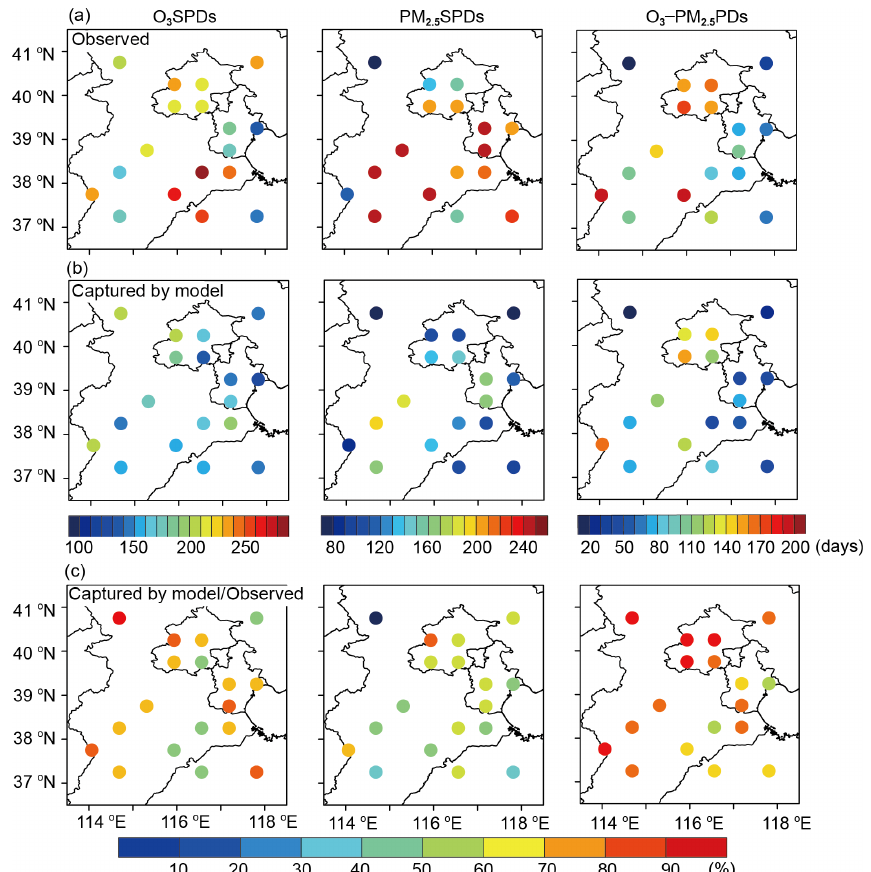
Figure 4. Spatial distributions of (a) observed numbers of O 3 SPDs, PM 2 . 5 SPDs, and O 3 –PM 2 . 5 PDs; (b) numbers of polluted days that were observed and also captured by the GEOS-Chem model with adjusted thresholds; and (c) percentages of observed polluted days that were captured by the model with adjusted thresholds. The values were calculated for the warm months (April to October) of 2013–2020.